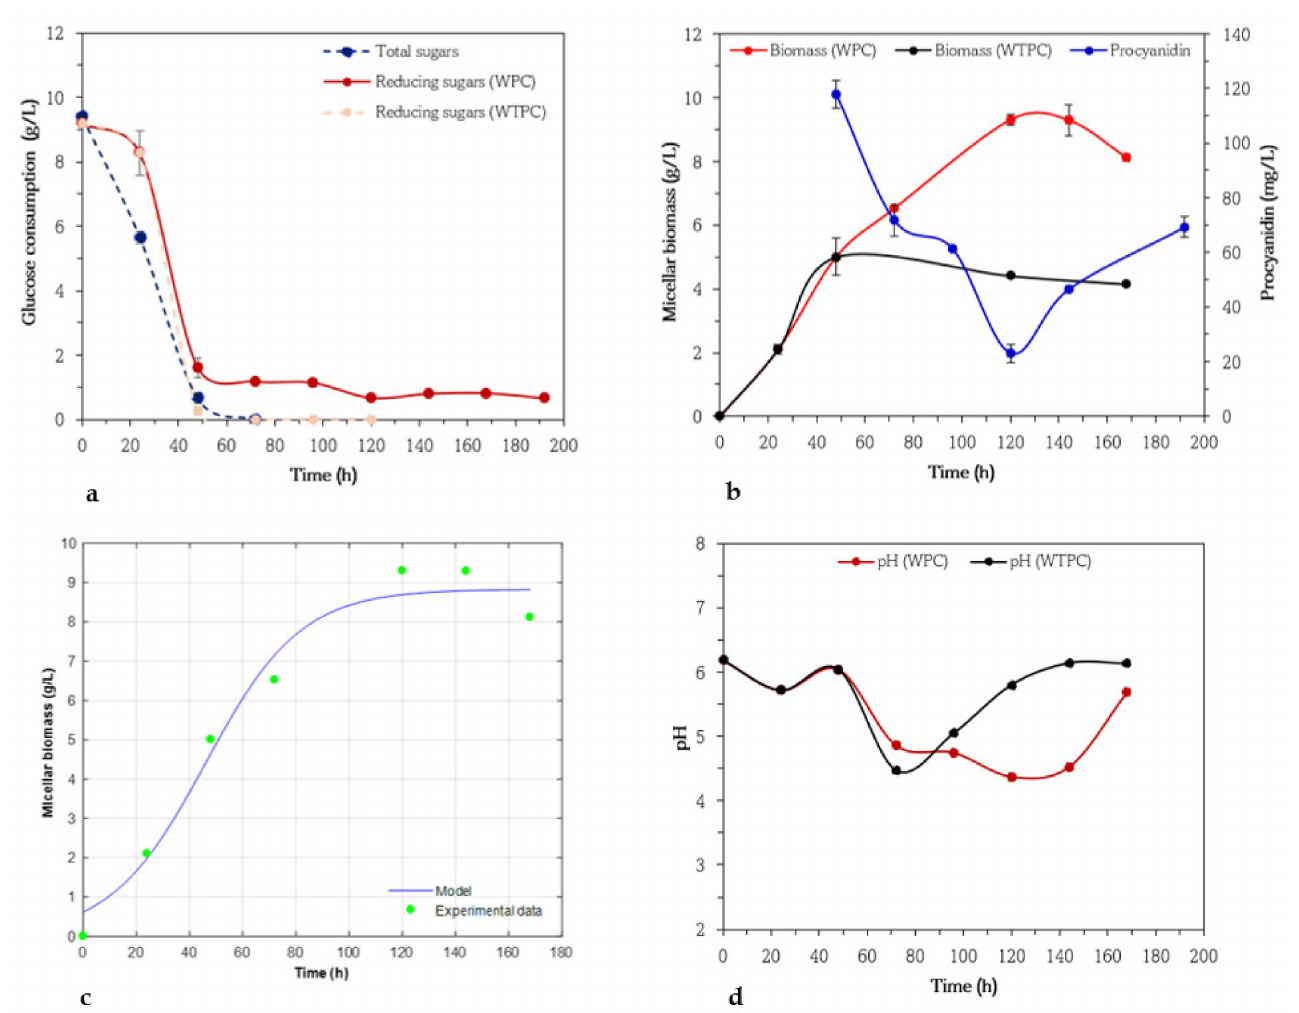
Figure 1. Variation of glucose concentrations by anthrone and 3,5 dinitrosalicylic acid (DNS) methods ( a ), micellar biomass in culture medium with (WPC) and without addition of procyanidins (WTPC) when glucose was below 3.0 g/L (stationary phase), and changes in procyanidin concentrations ( b ) in submerged cultures of Aspergillus niger 03. Micellar biomass production by Aspergillus niger 03 in submerged cultures using basic medium of salts and glucose (10 g/L) and with addition of procyanidin when glucose was below 3.0 g/L (stationary phase). Symbols represent experimental data. Solid lines represent calculated data ( c ), Evolution of pH in submerged cultures of Aspergillus niger 03 in medium with (WPC) and without (WTPC) addition of procyanidins when glucose was below 3.0 g/L (stationary phase) ( d